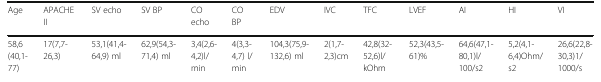
Table 1 (abstract 000630). See text for